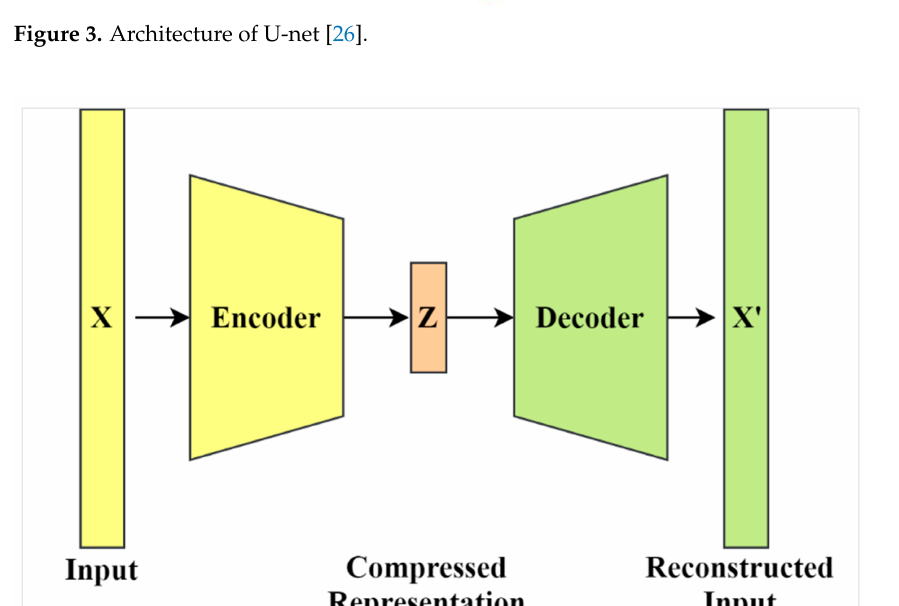
Figure 4. Architecture of auto-encoder